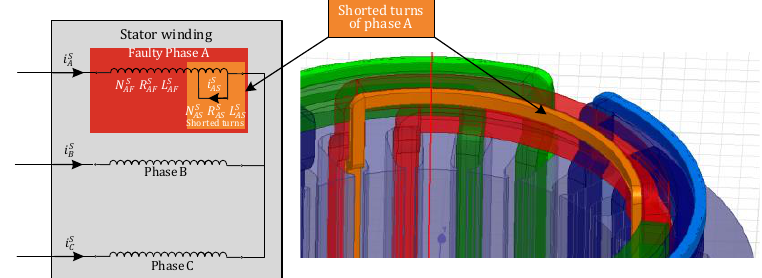
Figure 1. Illustration of the inter-turn short-circuit in the phase A of stator winding.